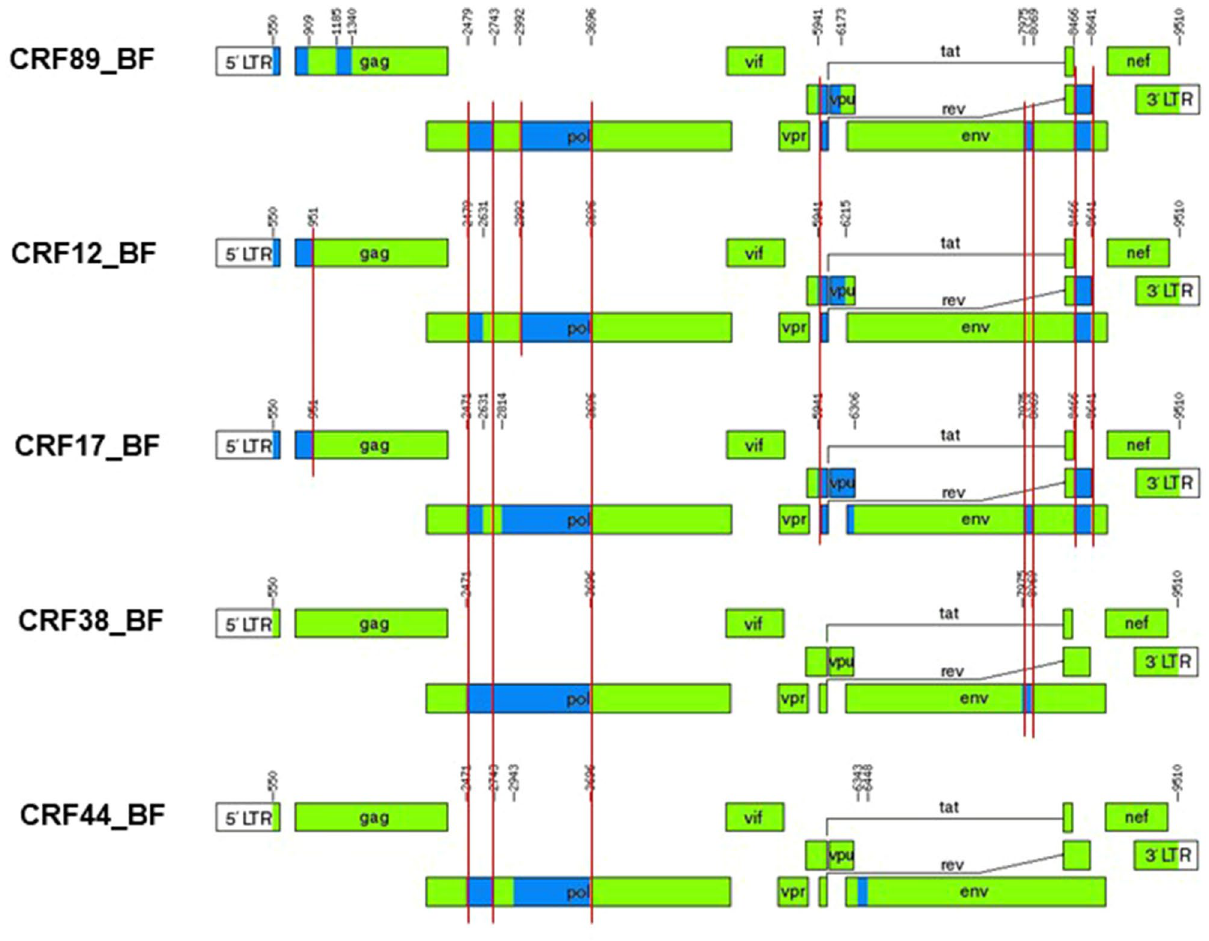
Figure 5. Mosaic structure of CRF89_BF compared to those of CRF12_BF, CRF17_BF, CRF38_BF, and CRF44_BF. Intersubtype breakpoints were determined as the midpoint of B-F1 75% consensus transitions (Supplementary Fig. S5). B and F1 fragments are shown in blue and green, respectively. Vertical red lines indicate coincident breakpoints. Positions correspond to the HXB2